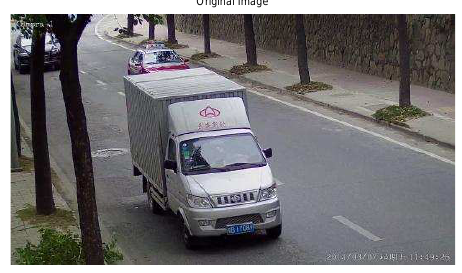
Fig. 1 Original image.